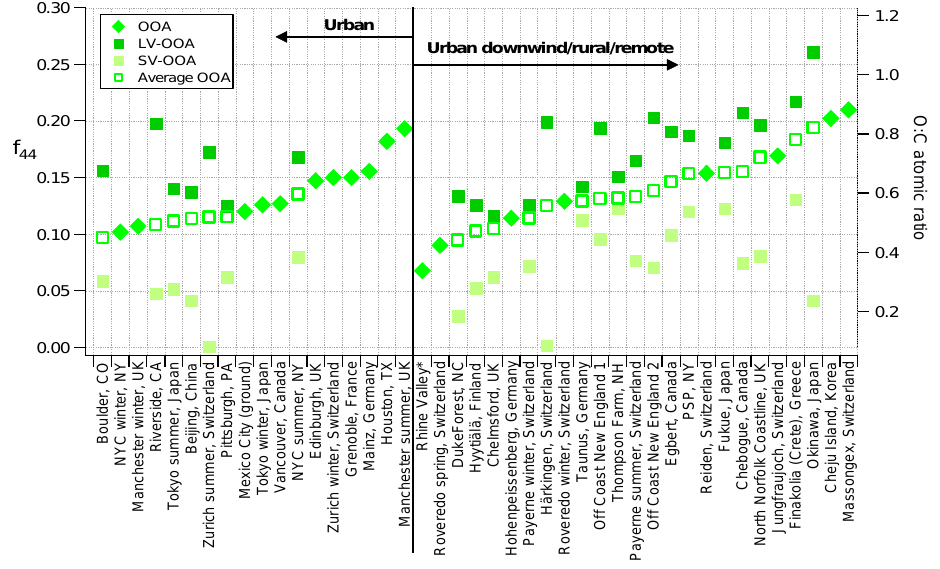
Fig. 3. f 44 and estimated O:C atomic ratios of the OOA, LV-OOA, and SV-OOA components at each site. The mass-weighted average OOA component over the entire campaign is also shown for sites in which LV-OOA and SV-OOA are both resolved. The sites within each location group are listed in increasing order of the f 44 and O:C ratio of the total OOA components and average OOA components. Uncertainties in f 44 of these components are discussed in the text. (Note: Rhine Valley*=Switzerland, Austria, and